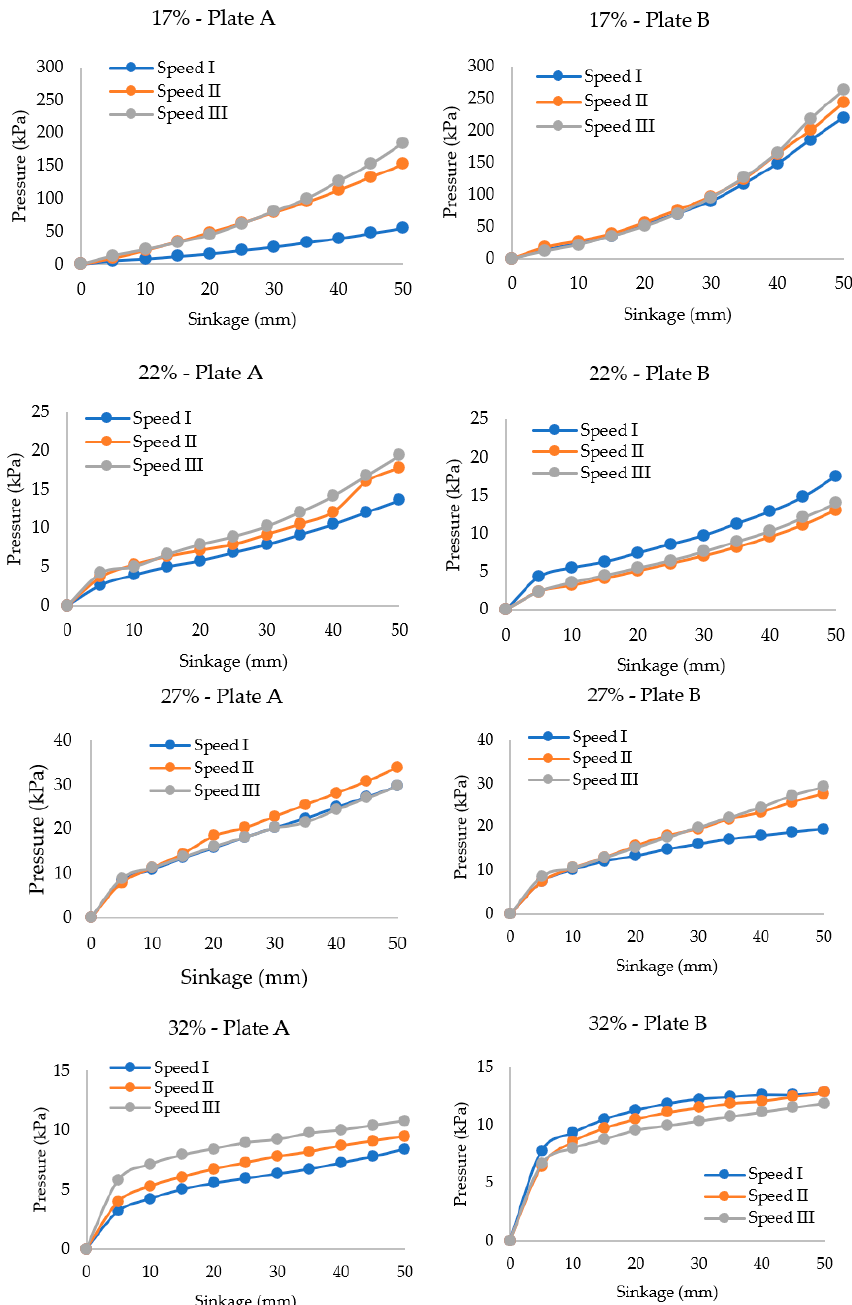
Figure 14. The relationship of pressure and sinkage under different moisture contents.